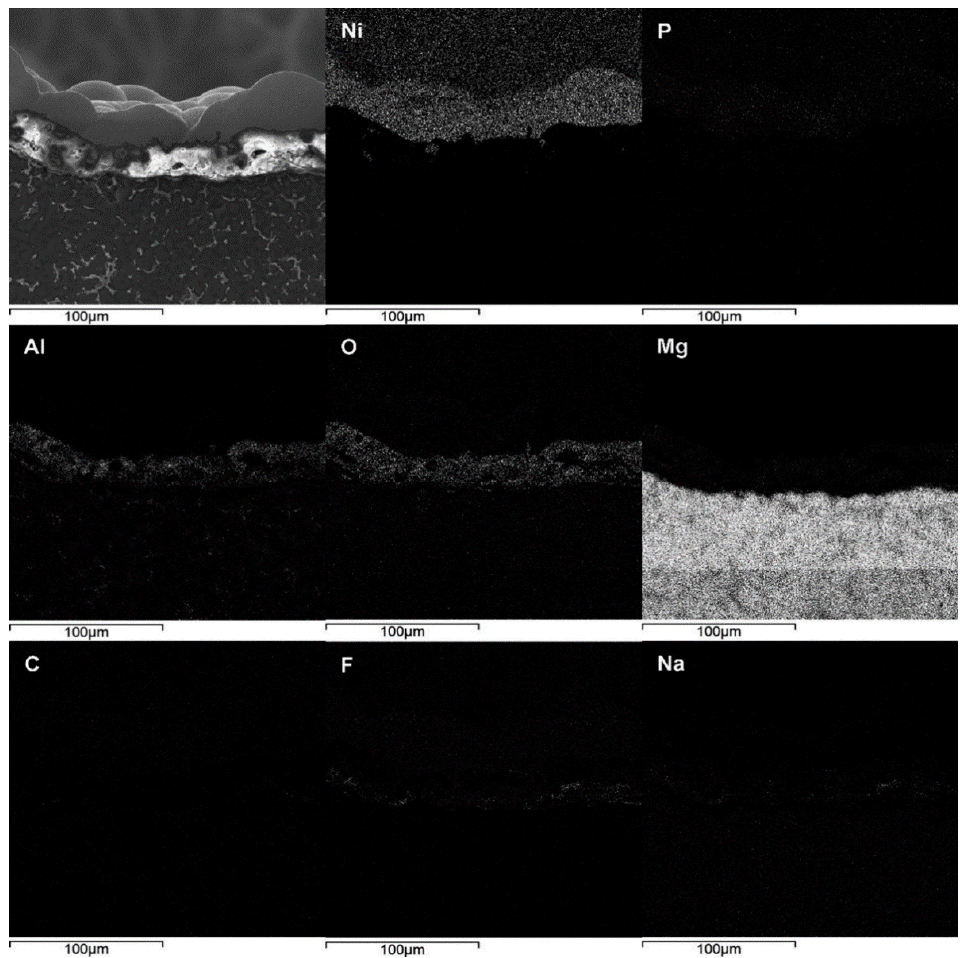
Figure 5. EDS analysis of the cross-section of the AZ91D hybrid foams: SEM image and composition distribution of Ni, P, Al, O, Mg, C, F and Na element.